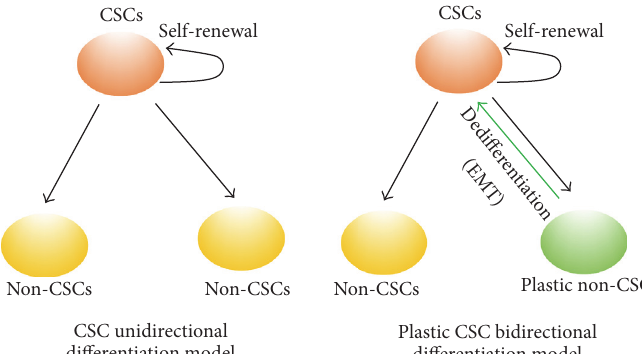
Figure 1: A schematic outlining the classical CSC unidirectional differentiation model and the plastic CSC bidirectional dedifferentiation model. In the unidirectional differentiation model, CSCs preexist in the tumor environment and solely self-renew or differentiate into the non-CSC tumor cells. However, in the plastic CSC bidirectional model, the plastic non-CSC tumor cells can dedifferentiate to acquire a CSC phenotype via epithelial-mesenchymal transition (EMT).